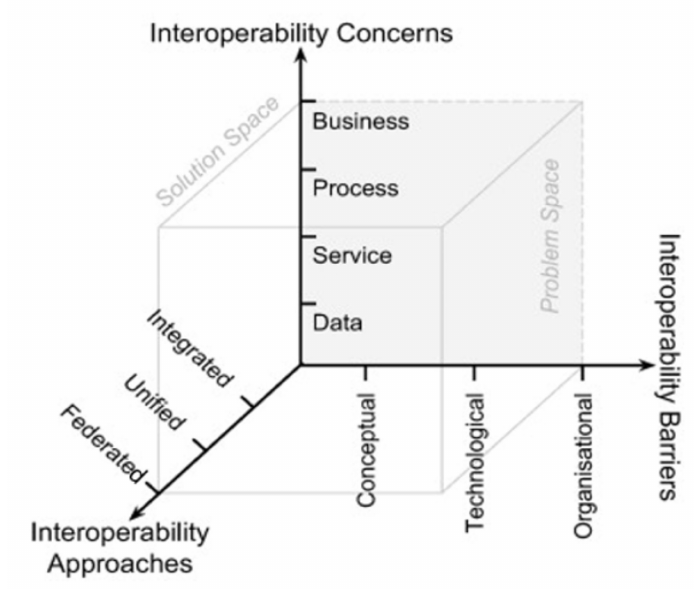
Figure 2. The Framework of Enterprise